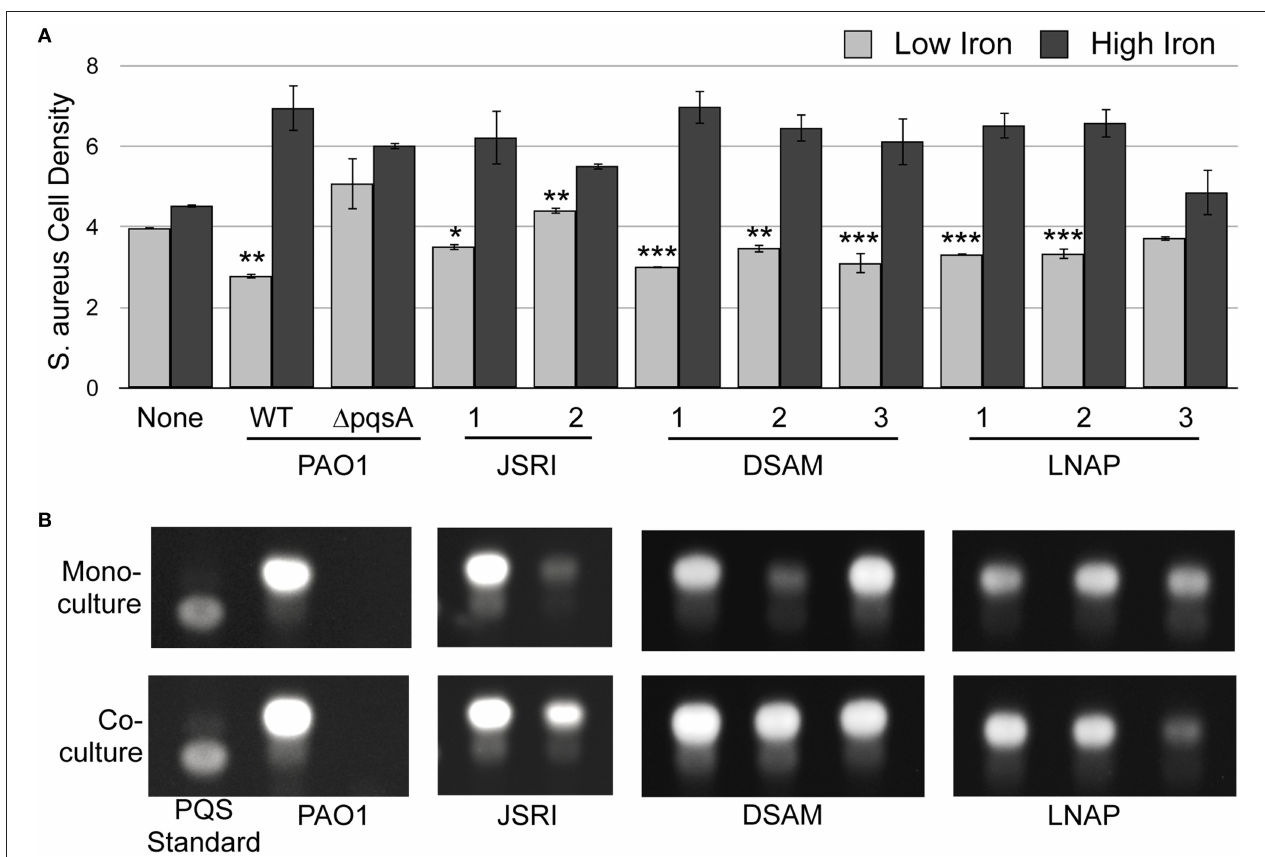
FIGURE 5 | S. aureus restores PQS production to several CF isolates of P. aeruginosa . (A) S. aureus cell density was measured spectroscopically as OD 630 after co-culture with the indicated P. aeruginosa strains in transwell cell culture plates as described in Section Materials and Methods. Error bars indicate standard deviation of three biological replicates. (*) Asterisks indicate the following p- values as determined by a two-tailed Student’s t- test: * p < 0.05, ** p < 0.005, *** p < 0.005 when comparing low iron to high iron. (B) TLC of P. aeruginosa laboratory strains and clinical CF isolates. P. aeruginosa strains were grown with or without S. aureus as indicated, and culture supernatant extracts were prepared and analyzed by as described in Section Materials and Methods. Images are representative of three biological